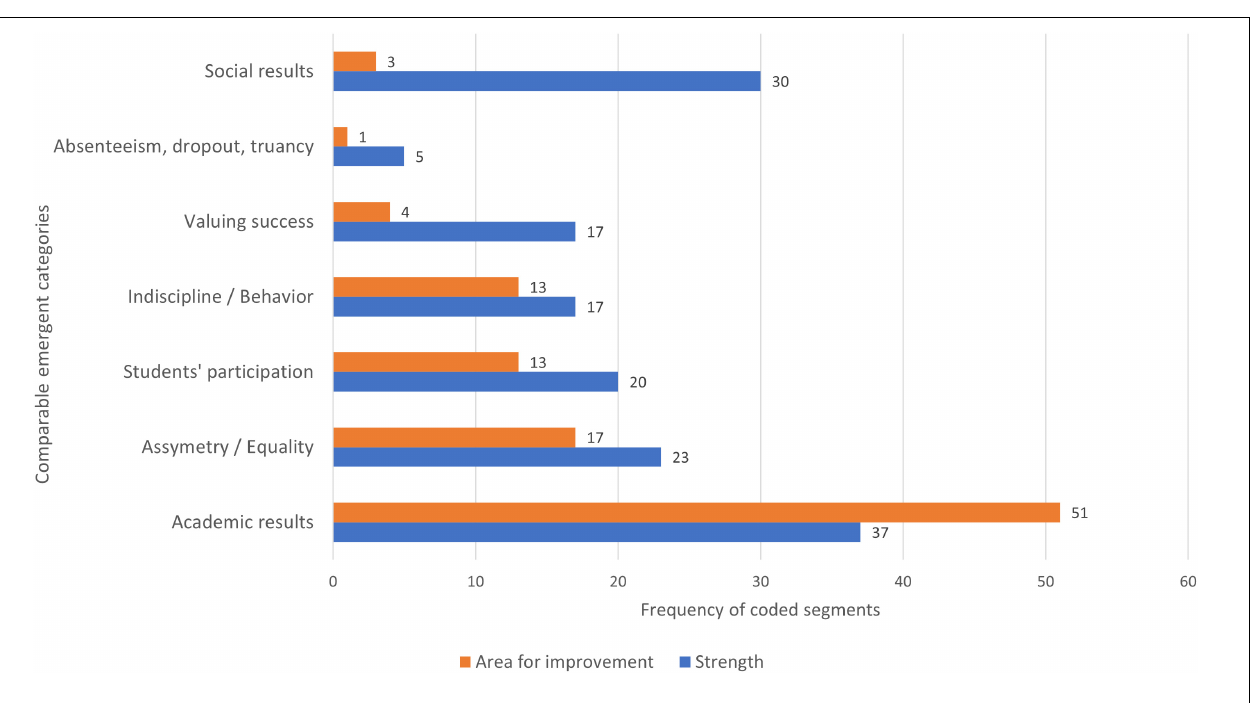
FIGURE 12 | Results: a comparison between strengths and areas for